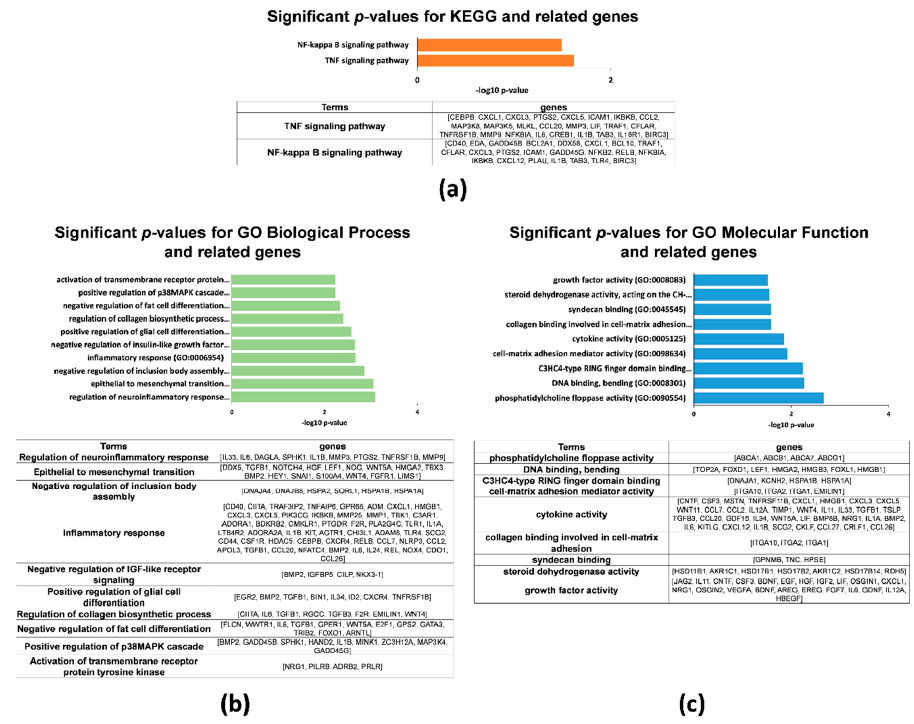
Figure 3. Functional enrichment analysis on KEGG pathways and Gene Ontology (GO) terms from the top 3000 upregulated genes in 3D vs. 2D hAMSCs. ( a ) Significant KEGG functional pathways ( p < 0.05). ( b ) Significant GO terms of associated biological processes ( p < 0.05). ( c ) Significant GO terms of associated molecular function ( p < 0.05).